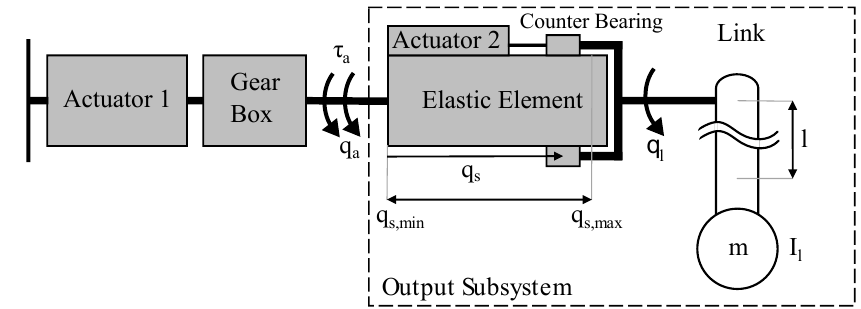
Figure 1. Sketch of the investigated pendulum driven by a variable torsion stiffness